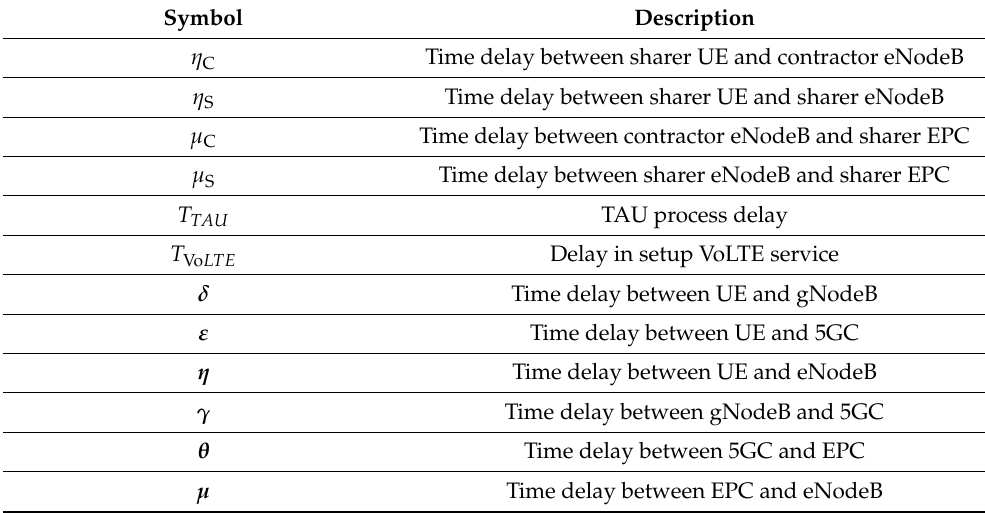
Table 1. Notation Description.